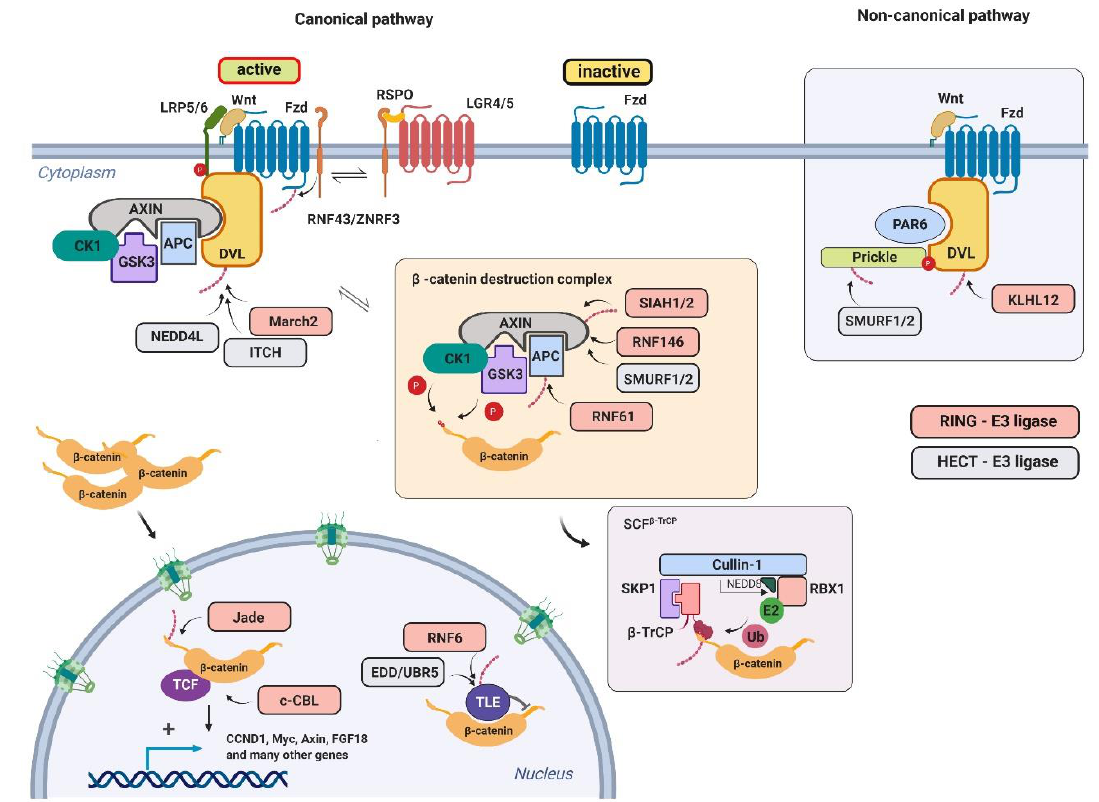
Figure 3. The Wnt signaling pathway and its regulation by ubiquitination The canonical Wnt signaling pathway is triggered by Wnt ligand binding to the complex of its receptor, Frizzled, and co-receptors LRP5 / 6. The activated receptor associates with the Dishevelled (DVL) protein and inhibits the β -catenin destruction complex. The stabilized β -catenin translocates and accumulates in the nucleus, where it activates the Wnt-dependent transcriptional program. For details see the text.